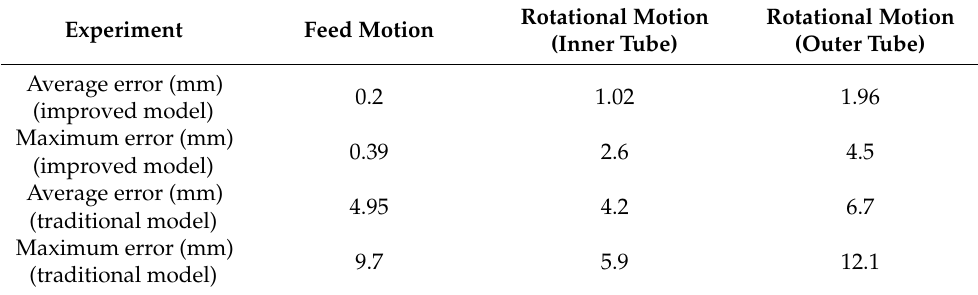
Figure 12. Improved model appearance rotating tip position error. Table 2. Experimental